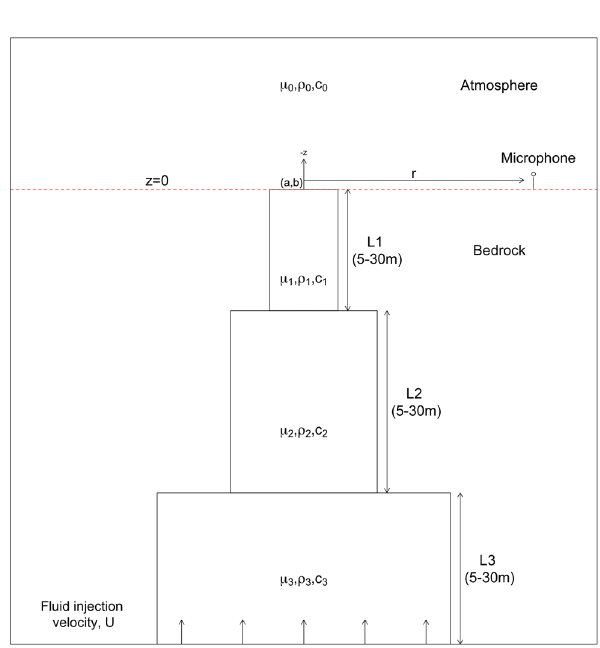
Figure 3: Simplified diagram demonstrating the ge- ometry and mechanism for the three-sectioned conduit resonance model Garcés [1997]. Geometric variables include the conduit section length L i , cross-sectional area S i , and distance from the vent to the recording mi- crophone r . Fluid properties such as the magma den- sity ρ i , viscosity µ i , and sound speed c i are unique to the flow regimes in each section of the conduit. Figure adapted from Figure 1 of Garcés